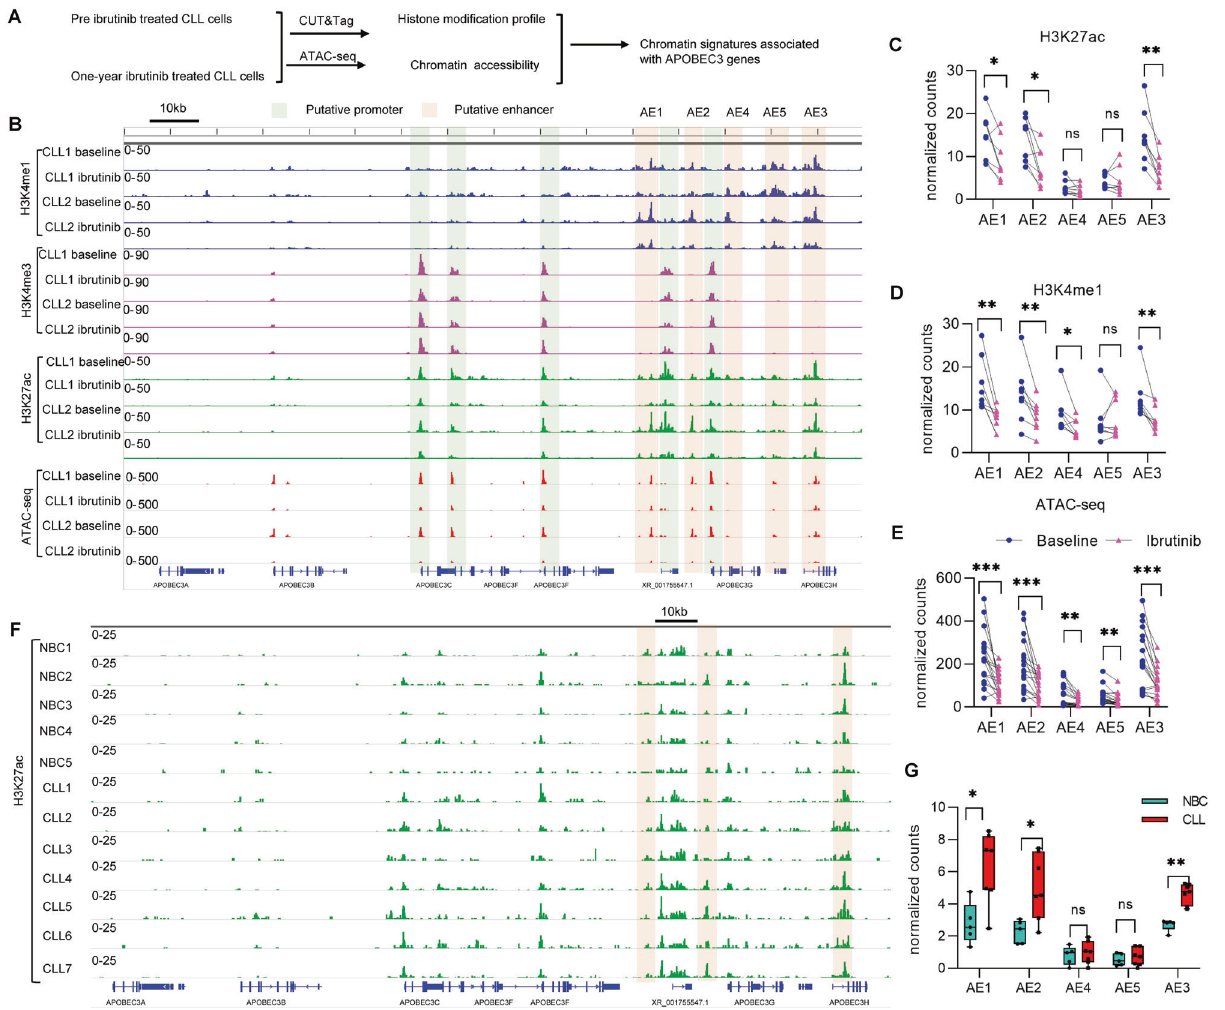
Fig. 2 Ibrutinib treatment suppresses the activity of putative enhancers of APOBEC3. A Schematic view of the analysis of epigenetic signatures of CLL B cells with 1-year of continuous ibrutinib treatment. B Genome tracks showing CUT&Tag of H3K4me1, H3K4me3, H3K27ac, and ATAC-seq pro fi les of putative APOBEC3 enhancers. Light green and brown shadows show promoters and enhancers respectively. baseline = pre ibrutinib treatment; ibrutinib = 1-year of continuous ibrutinib treatment. C – E Normalized read counts of the CUT&Tag ( n = 8) and ATAC-seq ( n = 18) pro fi les in panel ( B ). F Genome tracks showing H3K27ac pro fi les of APOBEC3 enhancers from CUT&Tag on normal and CLL B cells. The CLL and normal B cells were puri fi ed by negative selection of unwanted cells with tetrameric antibody complexes recognizing non-B cells and glycophorin A on red blood cells (RBCs) from PBMCs. G Normalized read counts of H3K27ac CUT&Tag pro fi le in panel ( F ) were shown (NBC, n = 5; CLL, n =